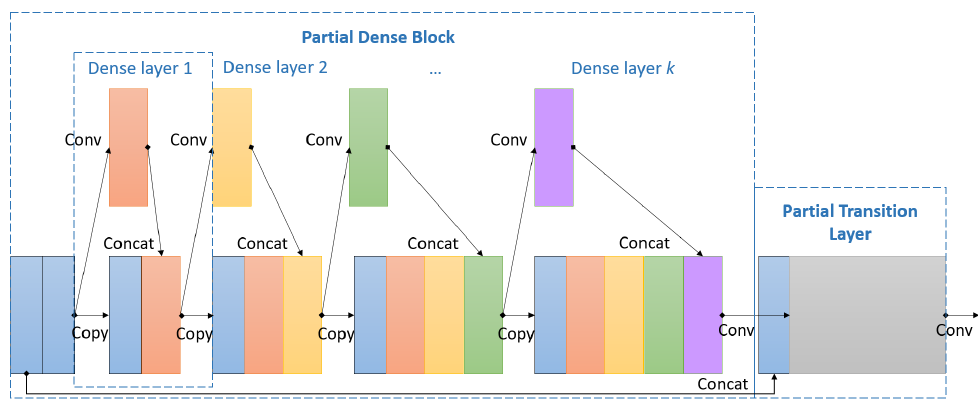
Figure 2. YOLOv5 backbone architecture processing each input